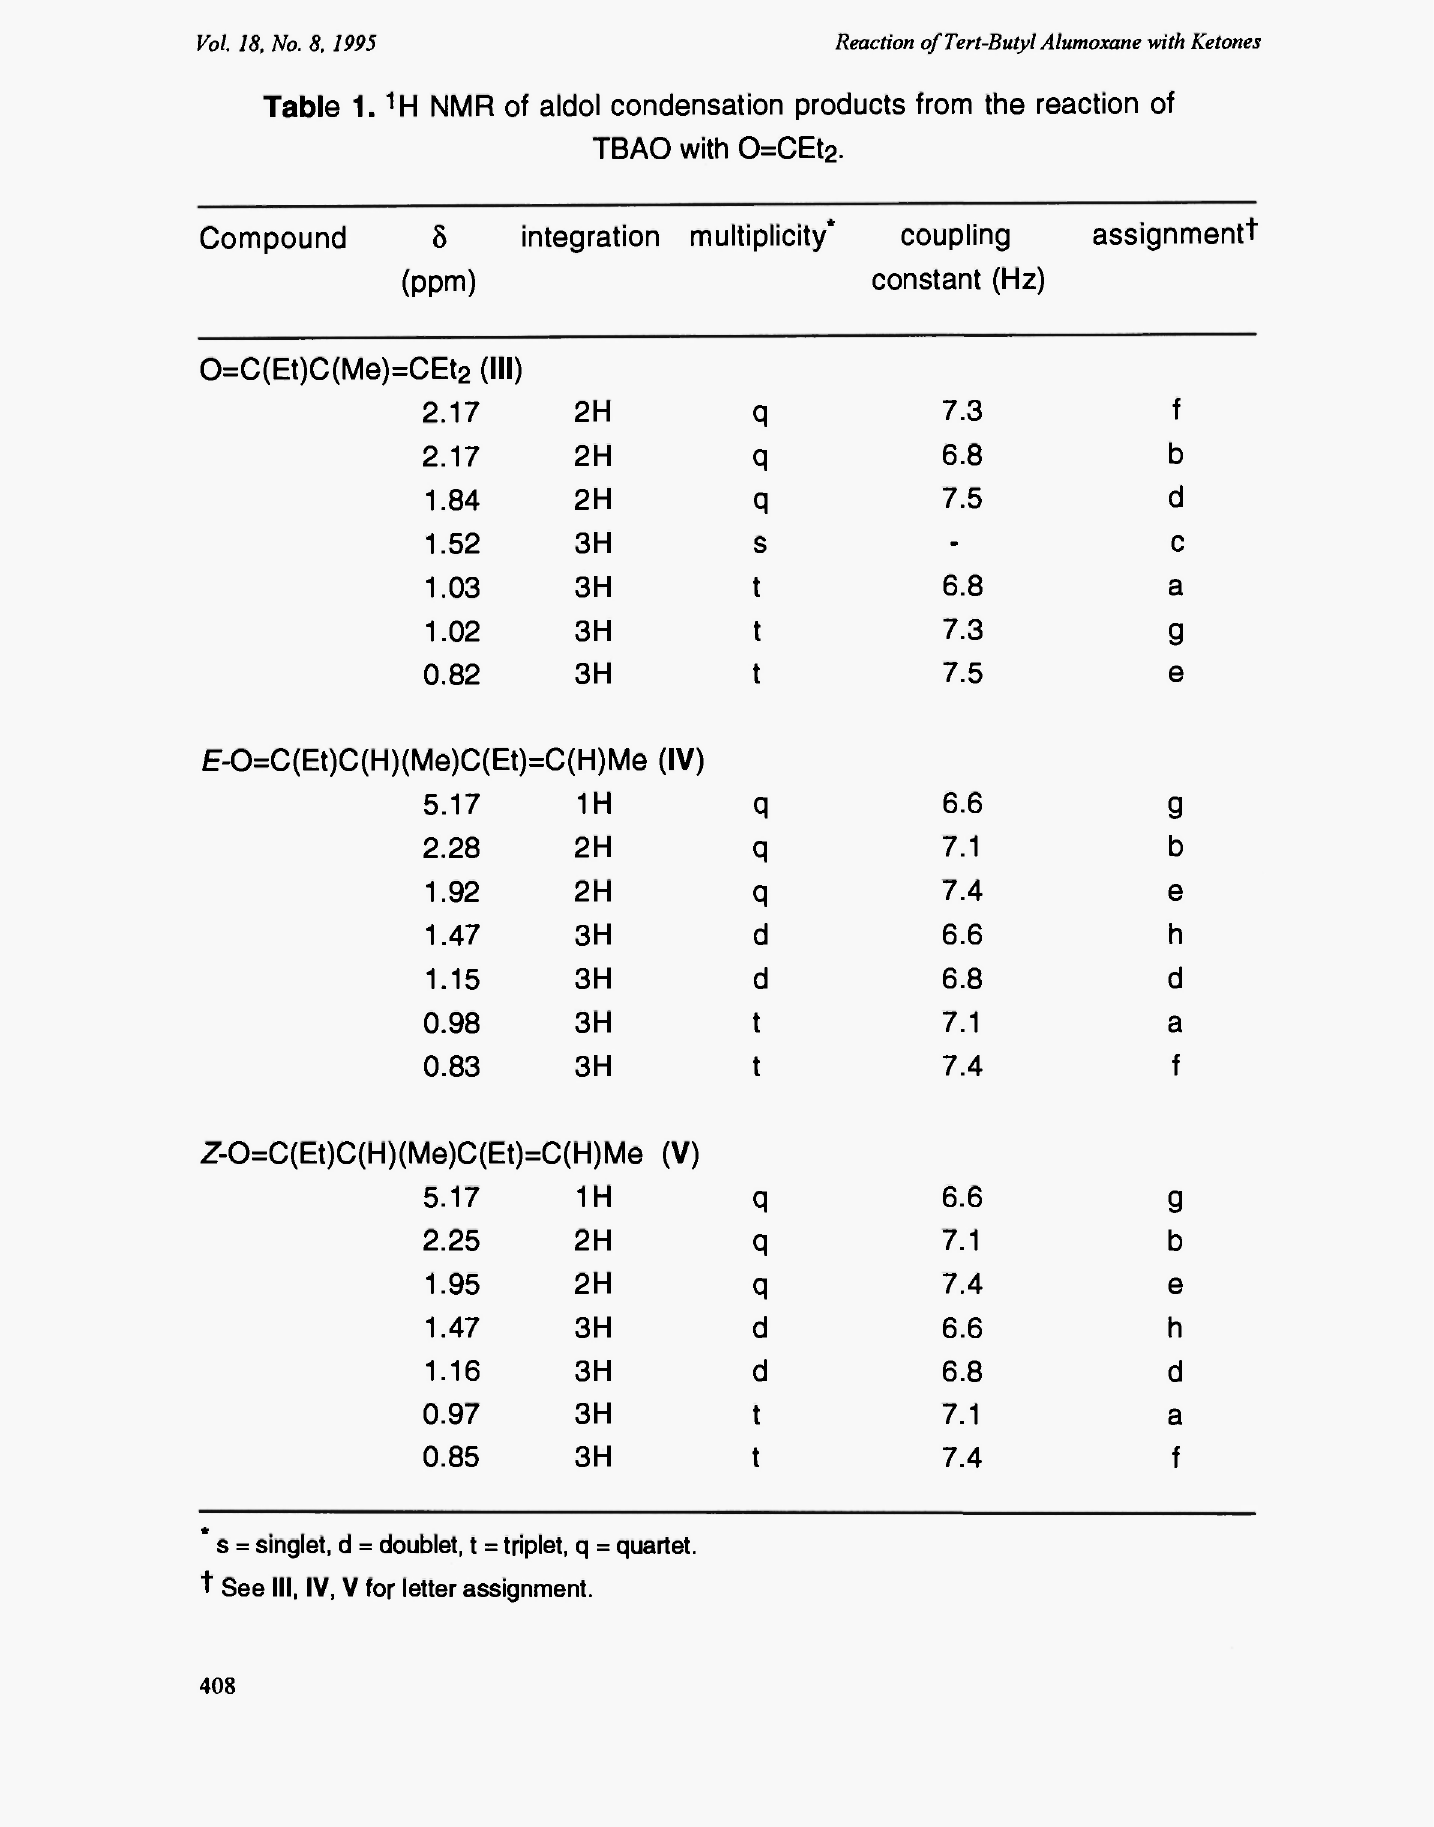
Table 1. 1 H NMR of aldol condensation products from the reaction of TBAO with 0=CEt 2